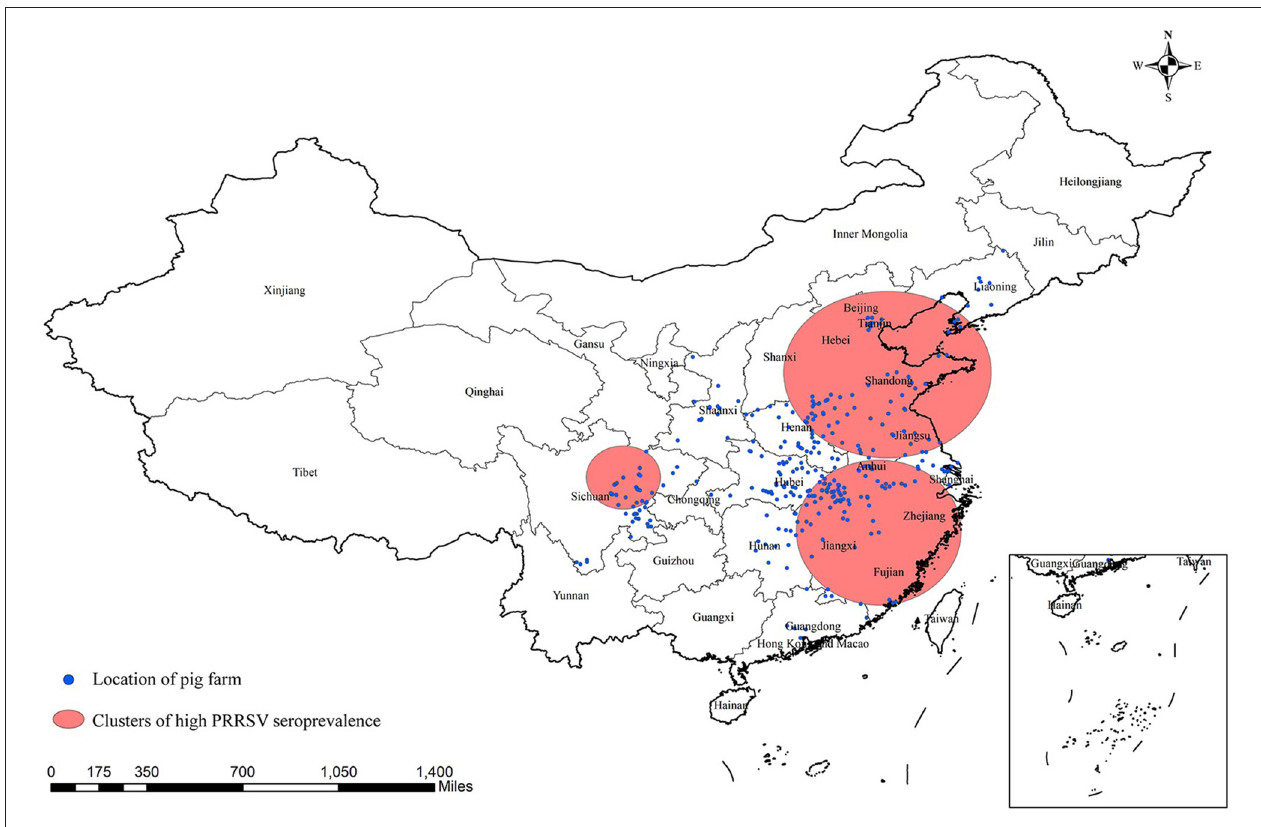
FIGURE 4 | Significant spatial clusters ( p -value < 0.05) of high PRRSV seroprevalence in China from December 2017 to May 2021 with a maximum window size of 25% of the population at